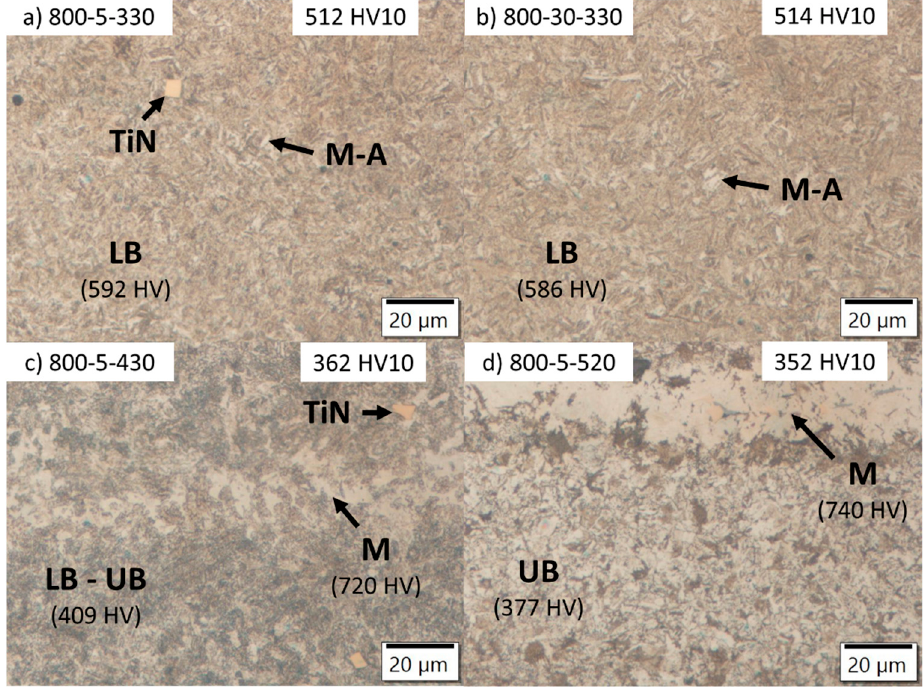
Figure 7. Optical microscopy of etched samples at 500× magnification after different heat treatments.